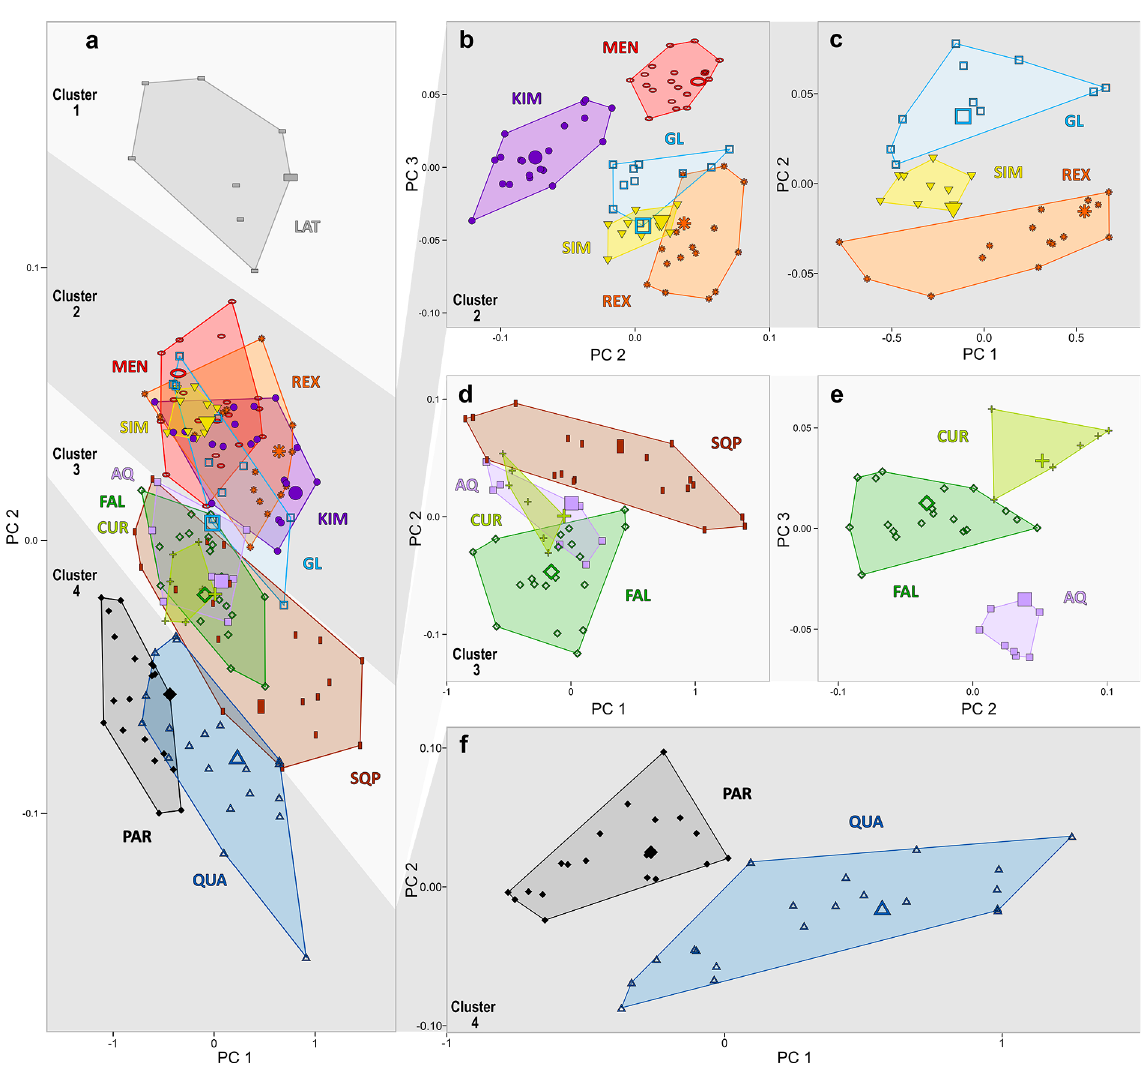
Fig. 3. Plots of principal component analyses of 21 measurements of 12 groups of Haplochromis from the Lake Edward system with a piscivorous morphology: H . sp. ‘latifrons’ ( ), H . mentatus Regan, 1925 ( ), H . sp. ‘rex’ ( ), H . sp. ‘simba’ (▼▼), H . sp. ‘glaucus’ (■), H . sp. ‘aquila’ (■■), H . sp. ‘kimondo’ (●●), H . sp. ‘falcatus’ ( ), H . sp. ‘curvidens’ ( ), H . sp. ‘pardus’ ( ), H . sp. ‘quasimodo’ ( ▲ ), and H . squamipinnis Regan, 1921 ( ██ ); holotypes are indicated by large symbols. a . Based on a PCA